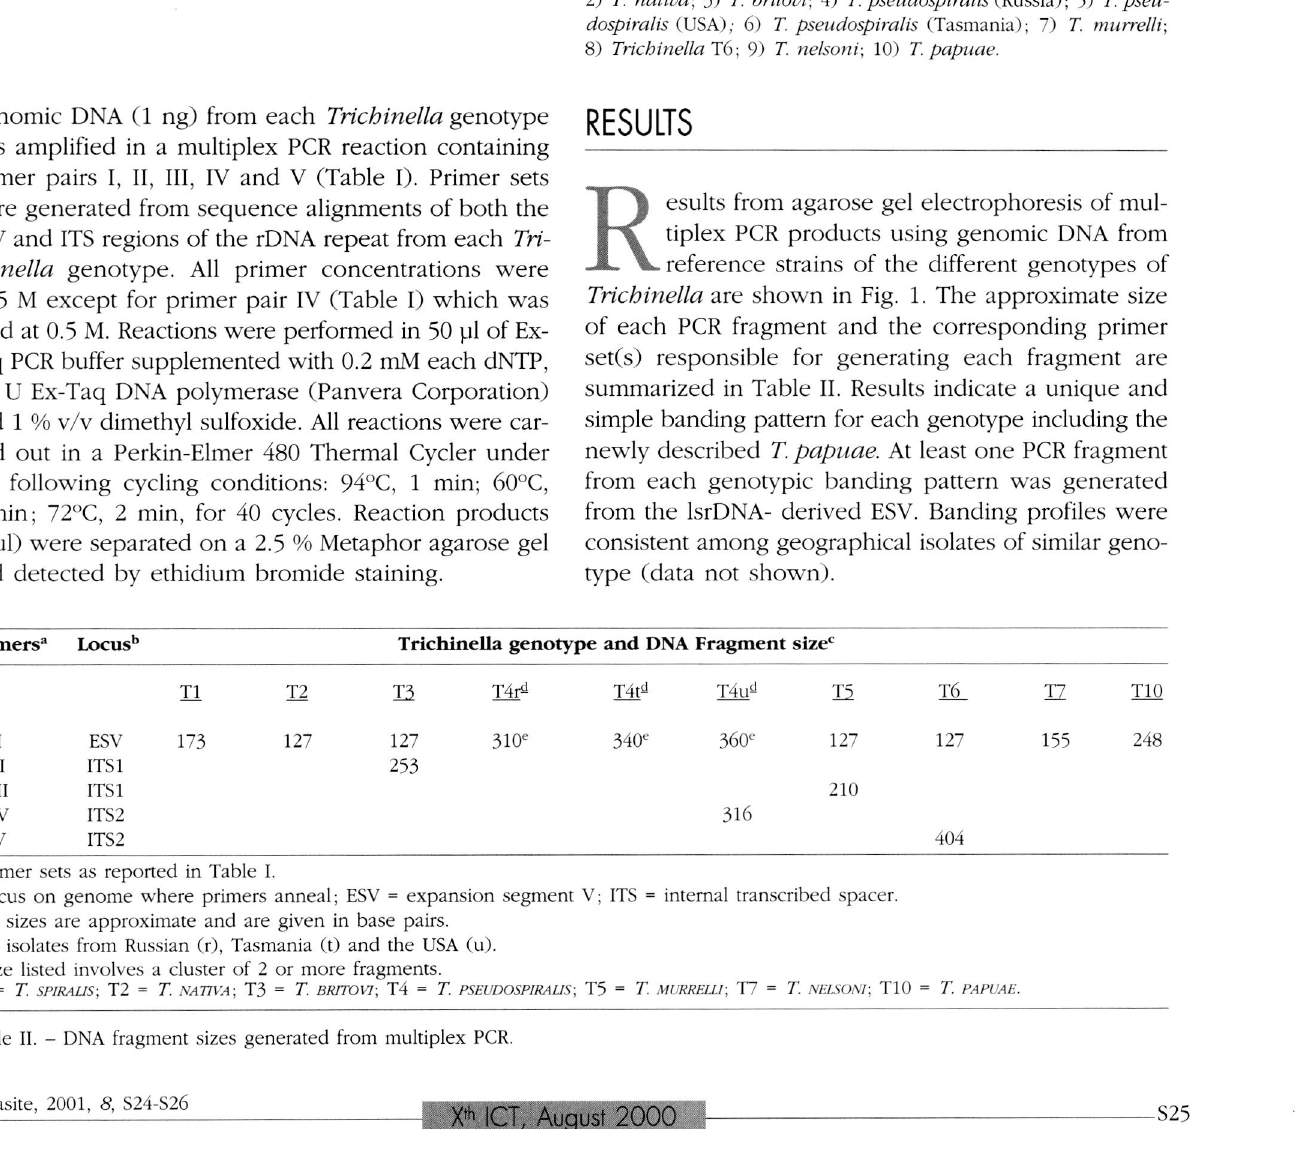
Parasite, 2001, 8, S24